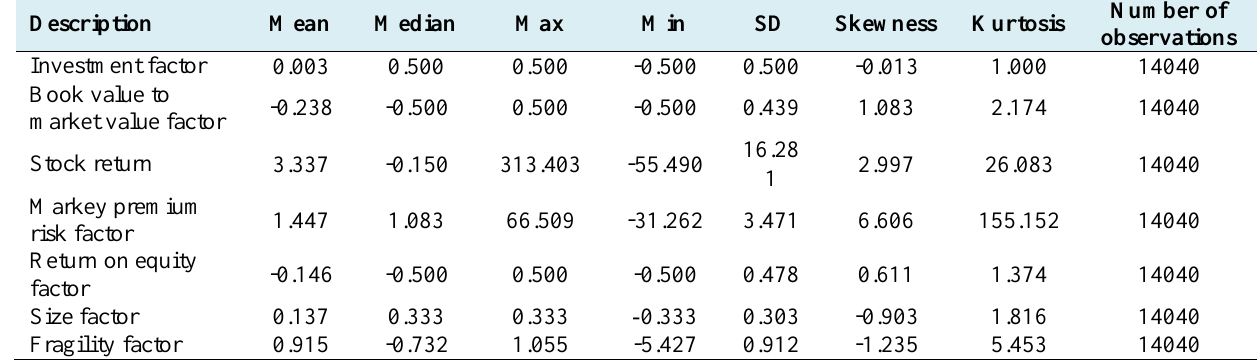
Table 1 . Descriptive statistics of research variables